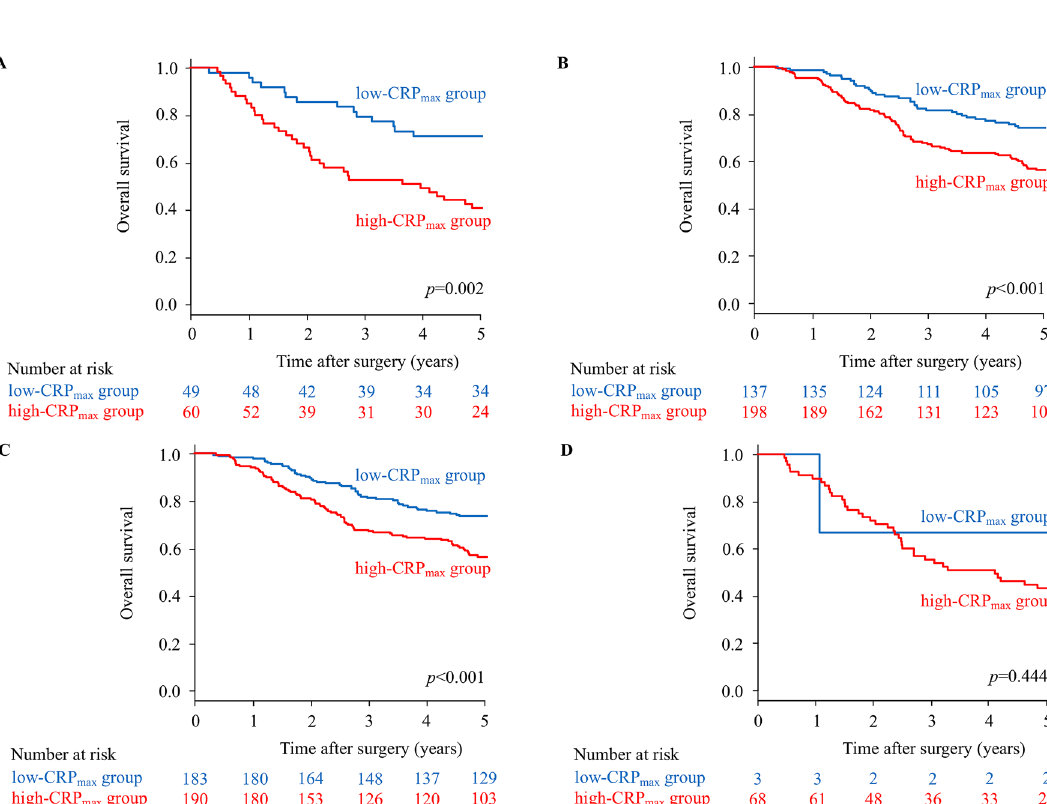
Table 3. Univariate and multivariate analysis for relapse free survival.